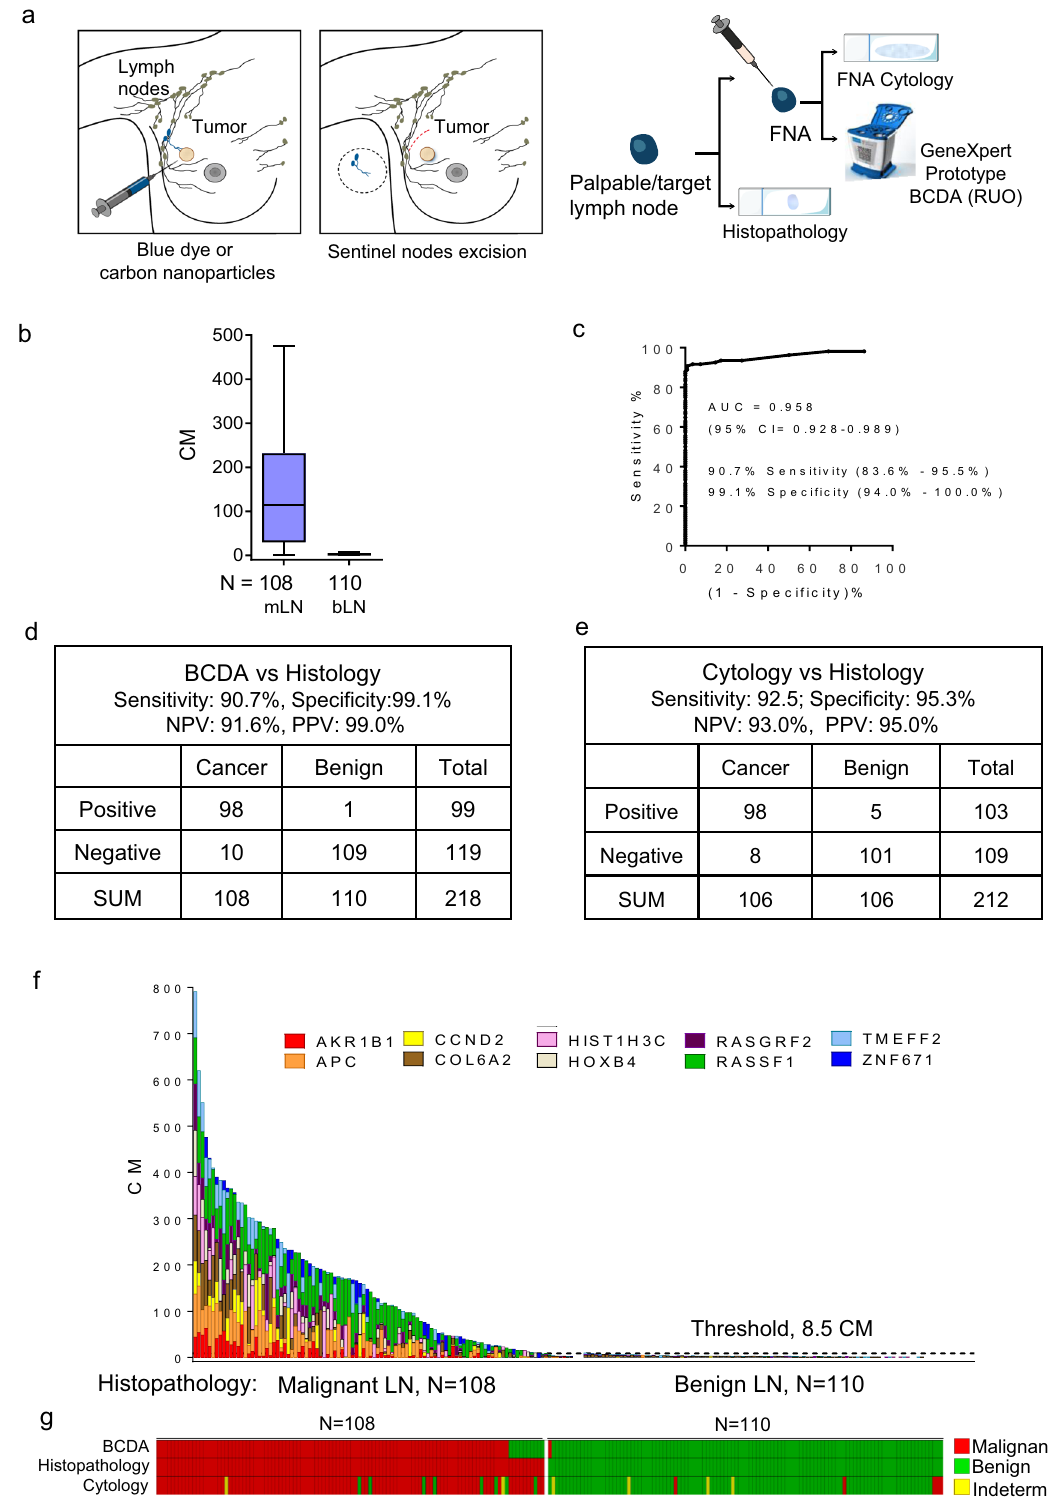
Cumulative methylation (CM), or sum of methylation of the ten gene-panel, was high in the majority of the malignant lymph nodes and low or absent in the benign. Analysis of the CM of all ten markers in the two groups, presented in the box plot, shows a signi fi cant difference in methylation between malignant